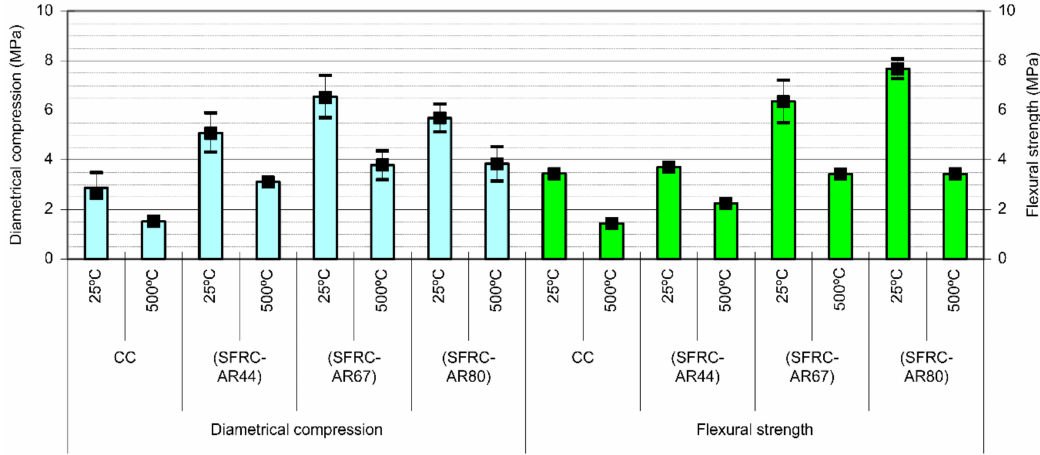
Figure 5. Diametral compression and flexural strengths of the non-fibrous and fiber-reinforced concrete